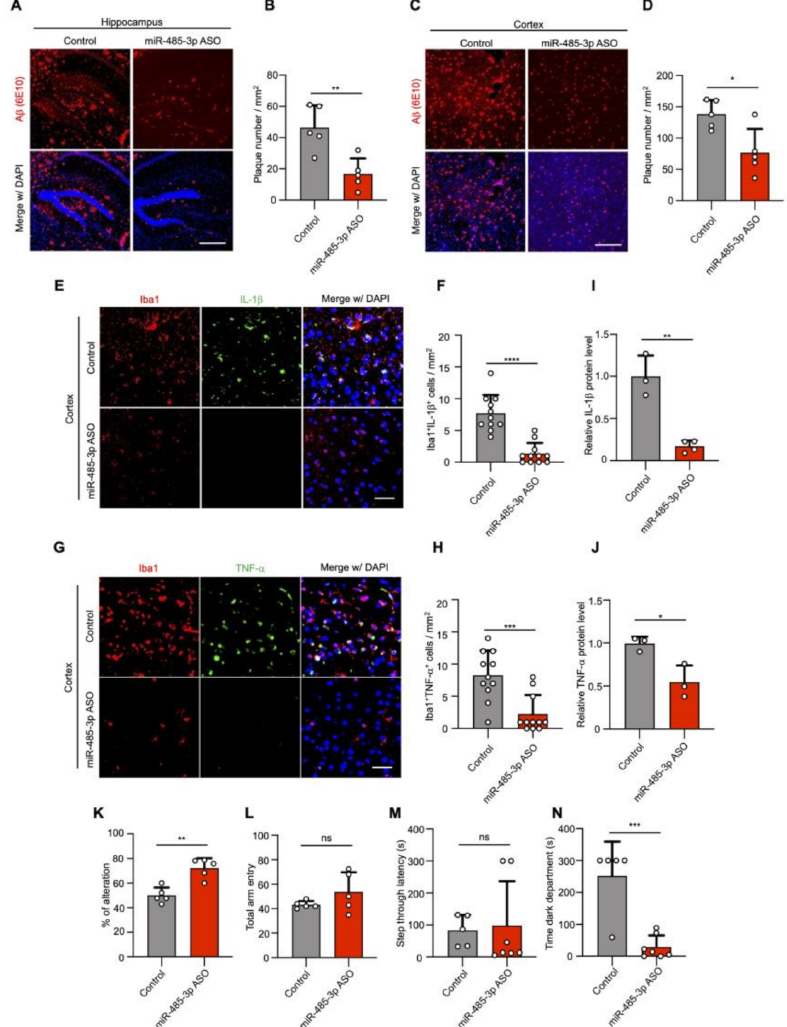
Figure 3. miR-485-3p antisense oligonucleotide (ASO) reduces A β pathology and neuroinflammation and rescues cognitive impairment. ( A – D ) Representative images of immunohistochemical staining with A β (6E10) in the hippocampus ( A ) and cortex region ( C ) after either control oligonucleotide or miR-485-3p ASO injection. Scale bars, 300 µ m. Quantification of the A β plaque in the hippocampus ( B ) and cortex region ( D ) (two-tailed t -test; n = 5; data are expressed as mean ± SD representing 1–3 randomly sampled regions, pooled from two independent experiments). ( E ) Representative images of immunohistochemical staining for Iba1 and IL-1 β in the cortex region of control- or miR-485-3p ASO-injected 8-month-old 5XFAD mice. Scale bars, 20 µ m. ( F ) Quantification of the Iba1 + IL-1 β cells from ( E ) (two-tailed t -test; n = 11; data are expressed as mean ± SD representing 1-4 randomly sampled regions, pooled from three independent experiments). ( G ) Representative images of immunohistochemical staining for Iba1 and TNF- α in the cortex region of control- or miR-485-3p ASO-injected 8-month-old 5XFAD mice. Scale bars, 20 µ m. ( H ) Quantification of the Iba1+ TNF- α cells from ( G ) (two-tailed t -test; n = 11; data are expressed as mean ± SD representing 1-4 randomly sampled regions, pooled from three independent experiments). ( I , J ) Protein expression of IL-1 β ( I ) and TNF- α ( J ) in the cortex of control- or miR-485-3p ASO-injected 5XFAD mice (data obtained across three independent experiments are expressed as mean ± SD). ( K – N ) Behavior tests in control- ( n = 5–7) or miR-485-3p ASO- ( n = 5–7) injected 8-month-old 5XFAD mice. Y-maze ( K , L ) analysis and passive avoidance testing ( M , N ) of control- or miR-485-3p ASO-injected 8-month-old 5XFAD mice. Average alternation (%) ( K ) for control- or and miR-485-3p ASO-injected 5XFAD mice and total entry number ( L ) into each arm on the Y-maze. Average step-through latency ( M ) and time in the dark compartment in seconds ( N ) for control- and miR-485-3p ASO-injected 5XFAD mice in passive avoidance tests. All data are presented as mean ± SD. ns, not significant; * p < 0.05; ** p < 0.01; *** p < 0.001; **** p < 0.0001 (two-tailed t